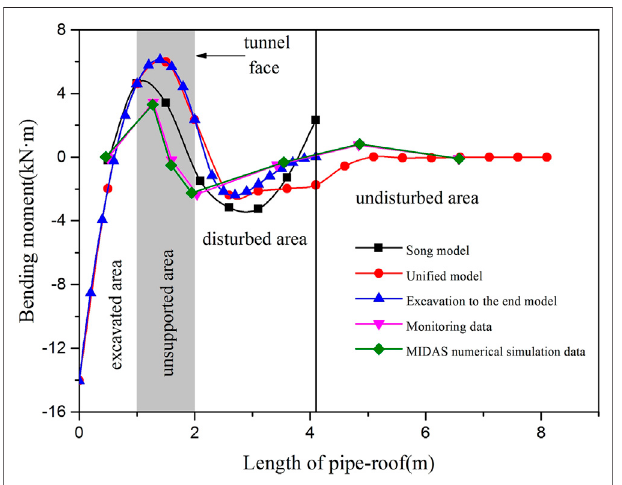
FIGURE 9 | The bending moment of the steel pipe in the pipe-roof. FIGURE 10 | The shear force of the steel pipe in the